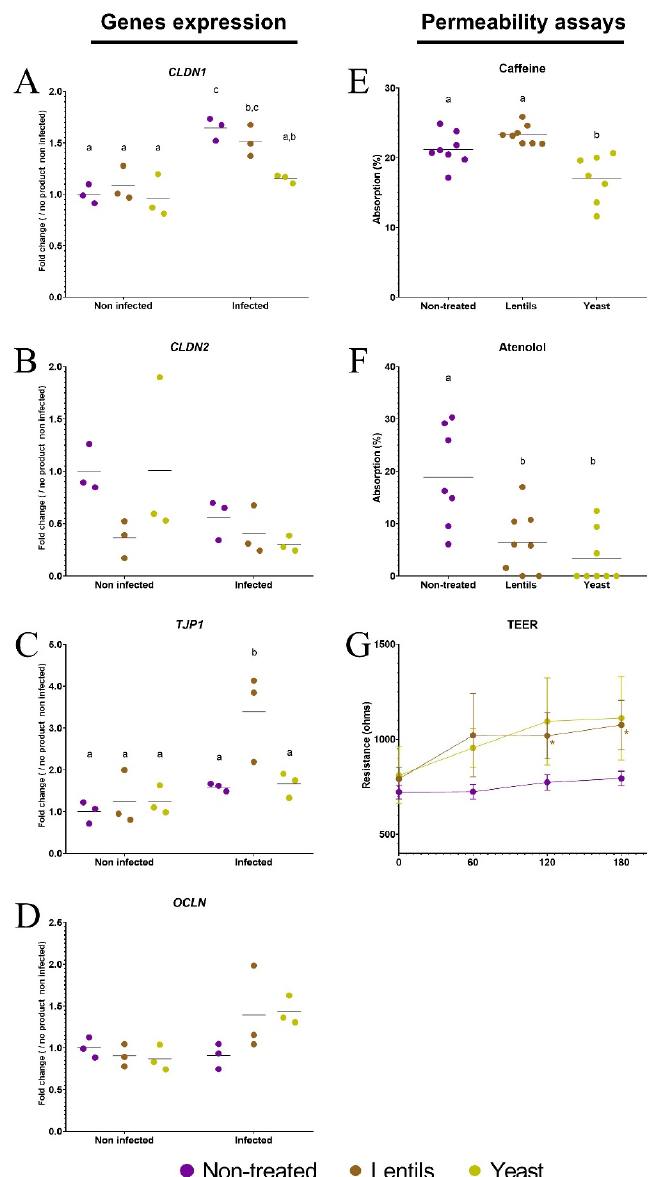
Figure 7. Modulation of intestinal epithelial permeability by fiber-containing products. Caco-2/HT29-MTX cells were infected with the ETEC strain H10407 (10 7 CFU · mL − 1 , MOI 100) after a 3 h pre-treatment with the lentil extract (brown dots, ‘lentils’) or specific yeast cell walls (yellow dots, ‘yeast’). Non-infected and non-treated conditions (purple dots, ‘non-treated’) were used as control experiments. ( A – D ) The expression of tight-junction-related genes ( CLDN1 , CLDN2 , TJP1, and OCLN ) was analyzed by RT-qPCR. The results are expressed as fold changes compared to the non-infected and non-treated control condition. ( E , F ) The absorption of caffeine (1 g · L − 1 ) ( E ) and atenolol (50 mg · L − 1 ) ( F ) after a 2 h co-incubation of Caco-2/HT29-MTX cells cultured on transwells with or without fiber-containing products. Permeability is given as a percentage of the initial apical concentration. ( G ) Transepithelial resistance (TEER) measured during a 3 h incubation period of Caco-2/HT29-MTX cultured on transwells with or without fiber-containing products. ( A – F ) represent individual replicates of three independent experiments with their means, while ( G ) represents the mean resistance ( ± SD) of three independent experiments. Conditions that are not different from each other according to Tukey’s multiple comparisons tests are grouped under the same letter ( p < 0.05). In panel ( G ), statistical differences with the non-treated control condition provided by Tukey’s multiple comparisons tests are indicated on the graph (*: p <